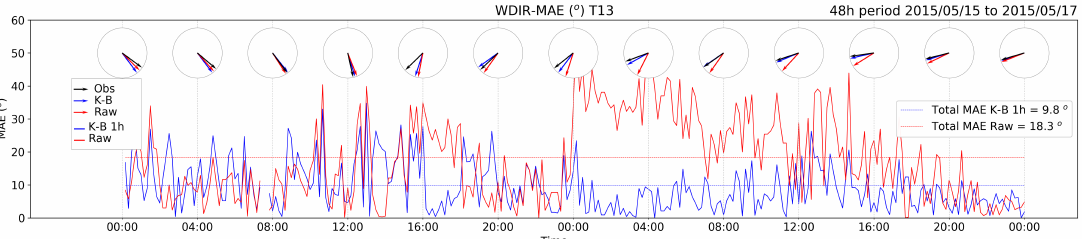
Figure 9. Wind direction MAE with K-B 1 h filter and RAW in W13 during a 48 h period. Wind direction arrows with observations, K-B 1 h, and RAW are displayed on top every four